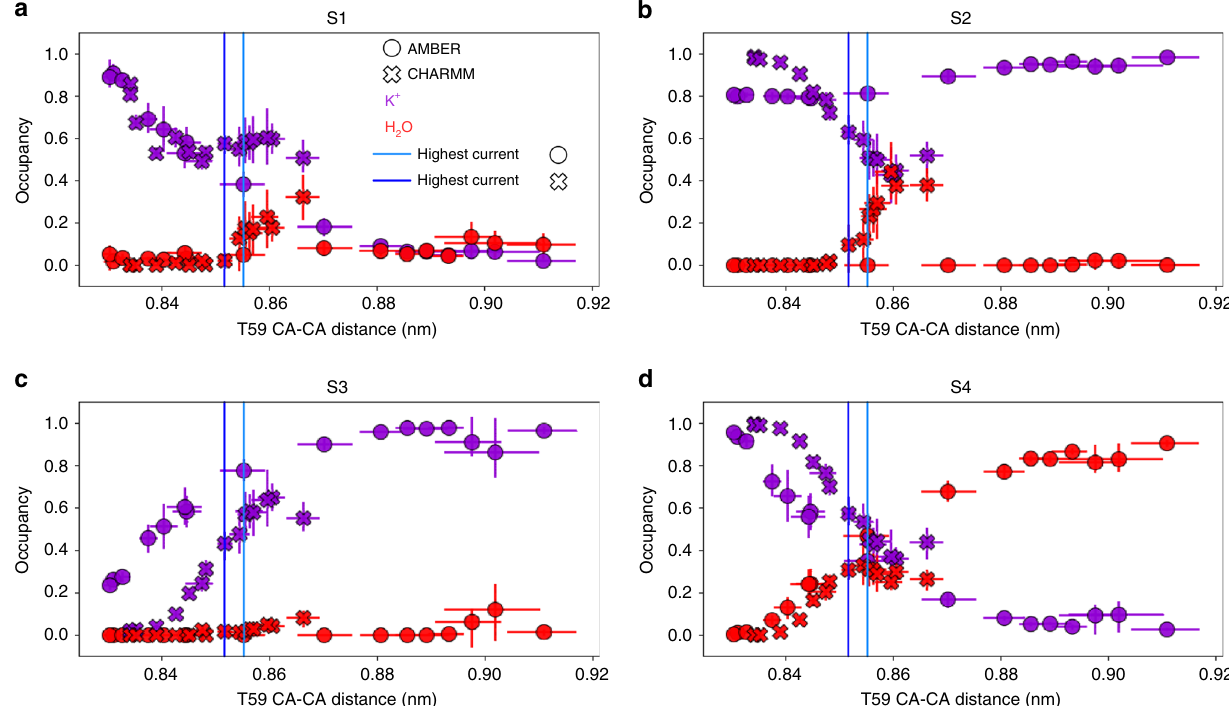
Fig. 4 Ion binding sites occupancy of the MthK SF as a function of the channel opening. A given site ( a S1, b S2, c S3, and d S4) can be occupied by a K + ion (purple), water (red), or be vacant (not shown), summing up to the total occupancy of 1. The openings for which the highest currents were recorded are shown as vertical lines. Error bars represent 95% con fi dence intervals. Source data are available as a Source Data fi